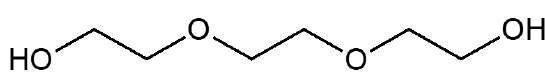
Figure 8. ( a ) Temperature, T , dependence of the hydration number, n H , per glucopyranose unit for HeC(1.3:90), HeC(2.0:220), and HeC(3.6:70) and that for triethylene glycol, TEG, per molecule. ( b ) T dependence of the hydration number, N H , per hydrophilic group for the HeC samples and TEG.